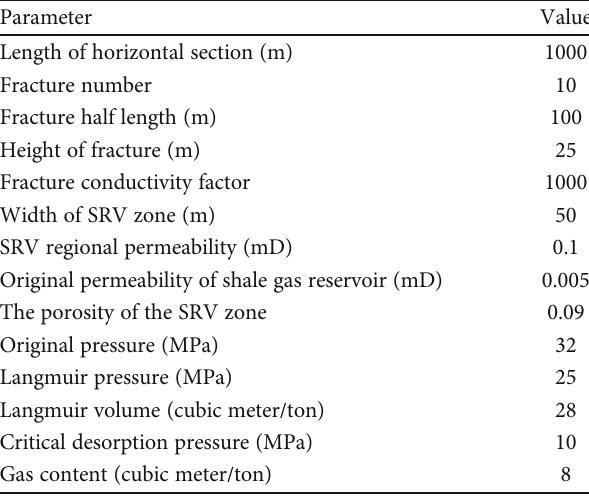
Table 1: Basic parameters of numerical simulation model.